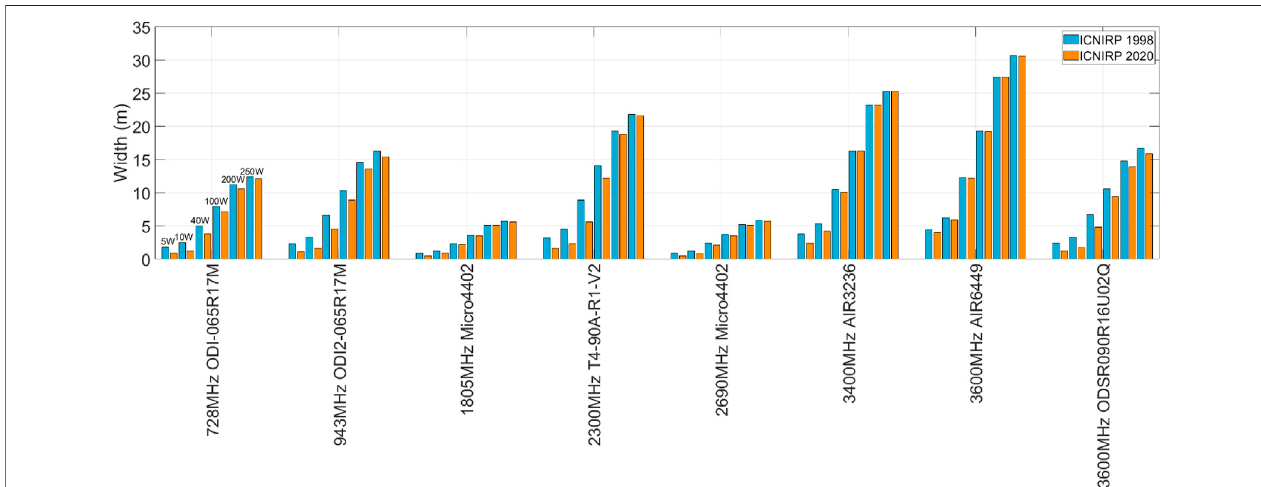
FIGURE 4 | Widths of the compliance boundary box for the selected BS antennas (for frequencies below 6 GHz) obtained by applying ICNIRP 1998 and ICNIRP 2020 general public reference levels for input powers of 5, 10, 40, 100, 200, and 250 W.